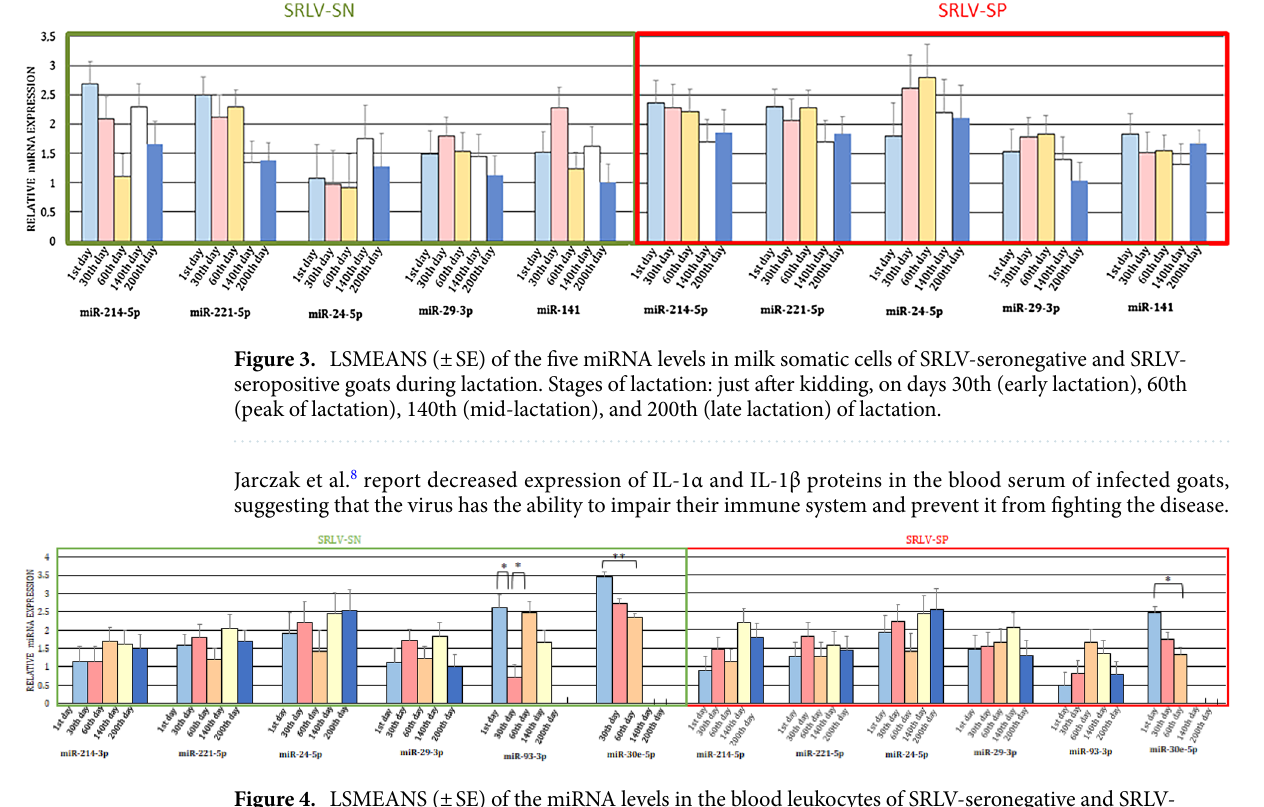
Figure 4. LSMEANS (± SE) of the miRNA levels in the blood leukocytes of SRLV-seronegative and SRLV- seropositive goats during lactation. The values within the same gene with star(s) differ significantly between stages of lactation: ** at p ≤ 0.01 and * at p ≤ 0.05. Stages of lactation: just after kidding, on days 30th (early lactation), 60th (peak of lactation), 140th (mid-lactation), and 200th (late lactation) of